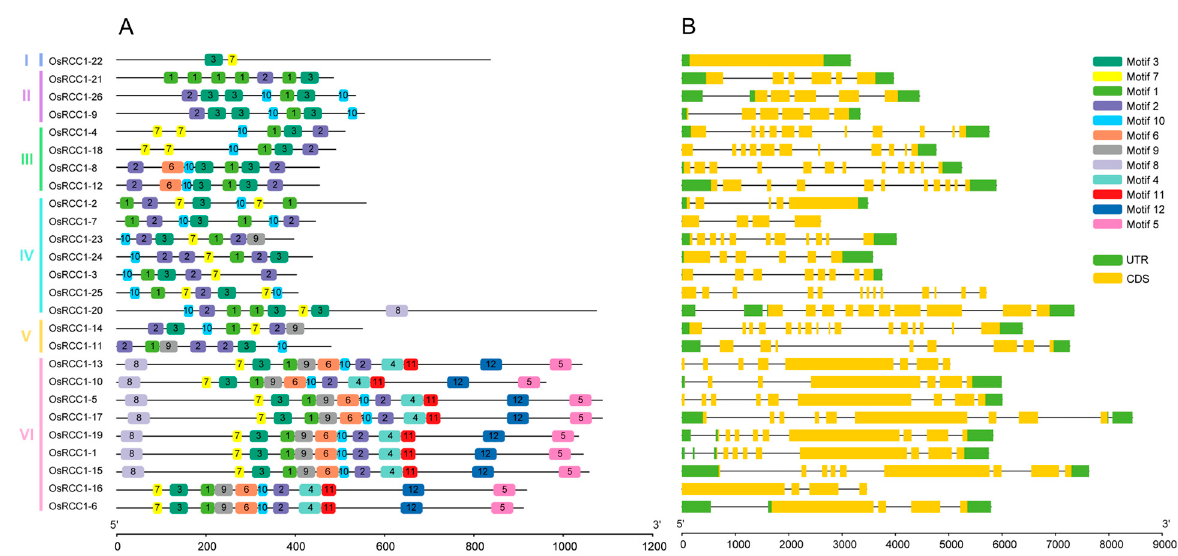
Figure 2. Conserved motifs and gene structures of OsRCC1s. ( A ) Motif patterns of OsRCC1s. Boxes with different colors represent various conserved motifs. ( B ) Exon/intron architectures of OsRCC1s. Introns, exons and untranslated regions are represented by black lines, yellow boxes and green boxes, respectively.